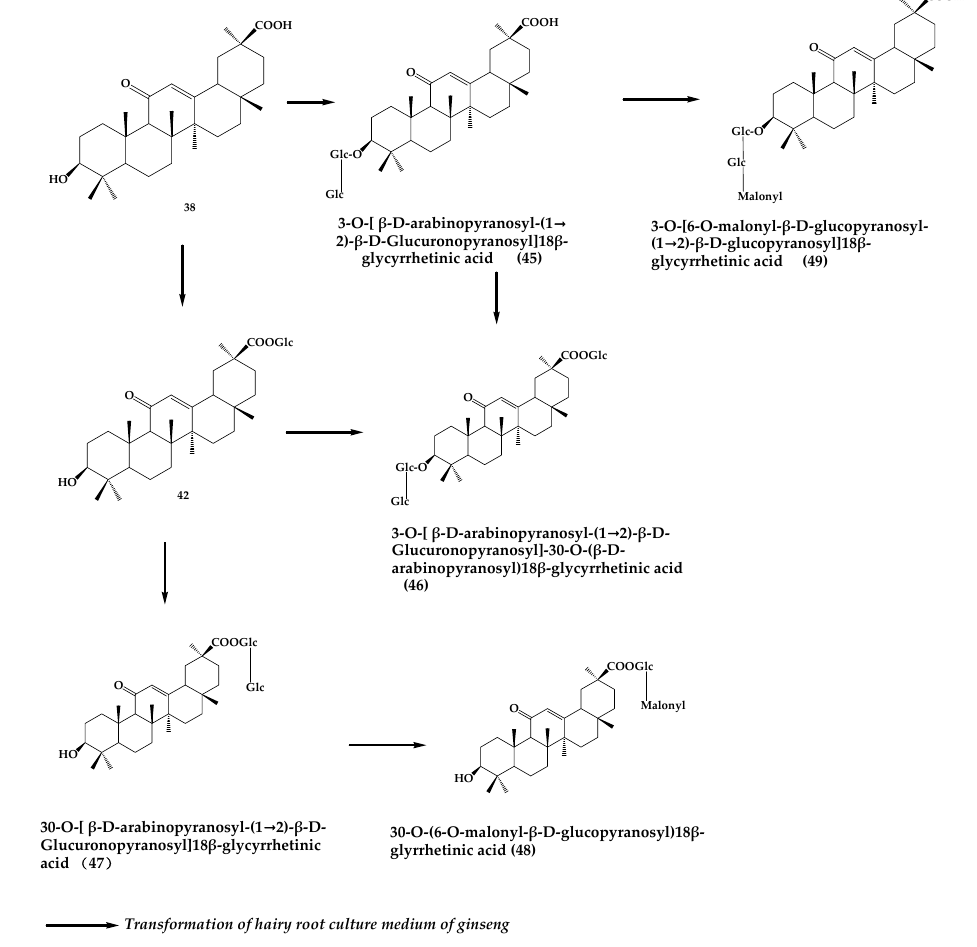
Figure 9. Glycyrrhetinic acid conversion pathway.